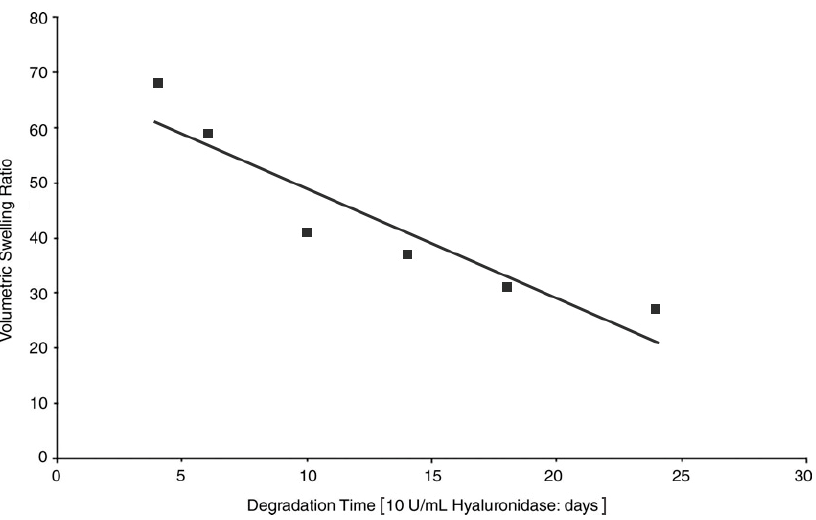
Figure 3. Comparison of swelling ratio and degradation time for six selected chemically modified thiolated HA variants. Increased swelling correlated with rapid degradation. Adapted from Orlandi et al. [46].